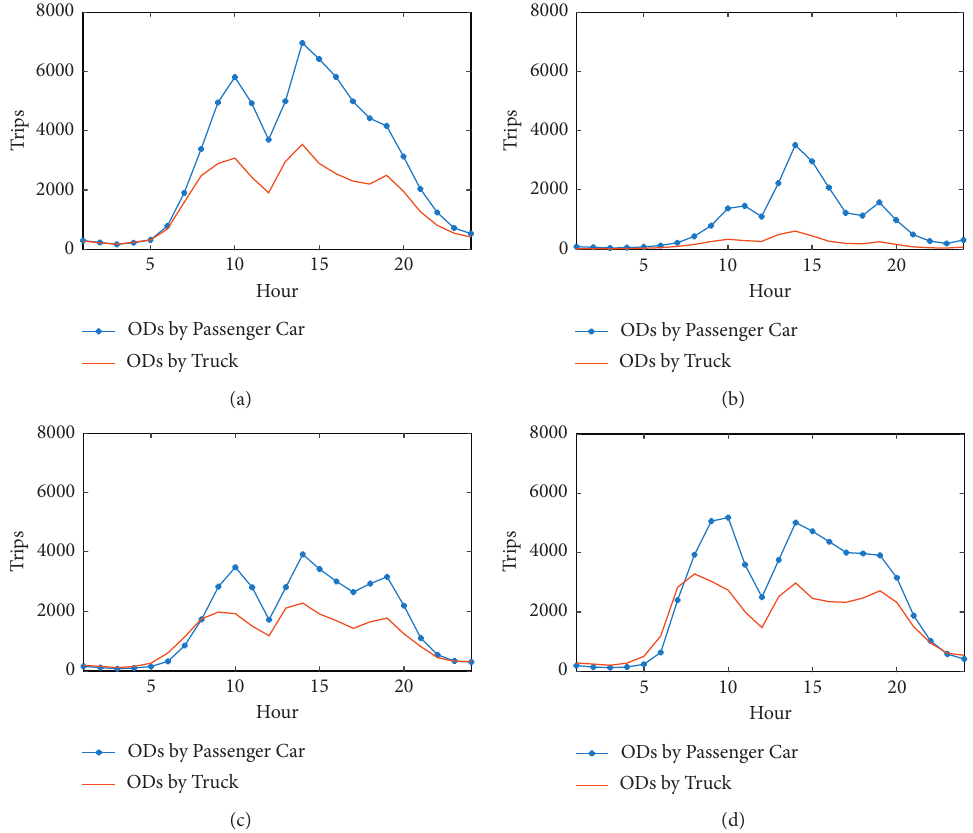
Figure 6: Hourly average numbers of the OD flows for Changsha-Yueyang using different types of vehicles in the four time periods. (a) before the outbreak, (b) during the outbreak, (c) during the return to work and production and (d) after Wuhan was the average hourly numbers of the OD flows using different types of vehicles in the four time periods.